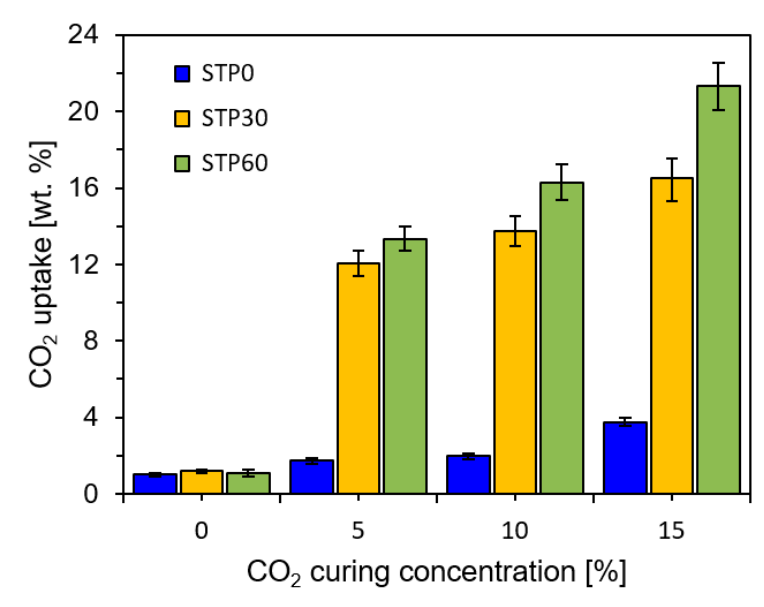
Figure 11. CO 2 uptake for specimens according to CO 2 concentration.